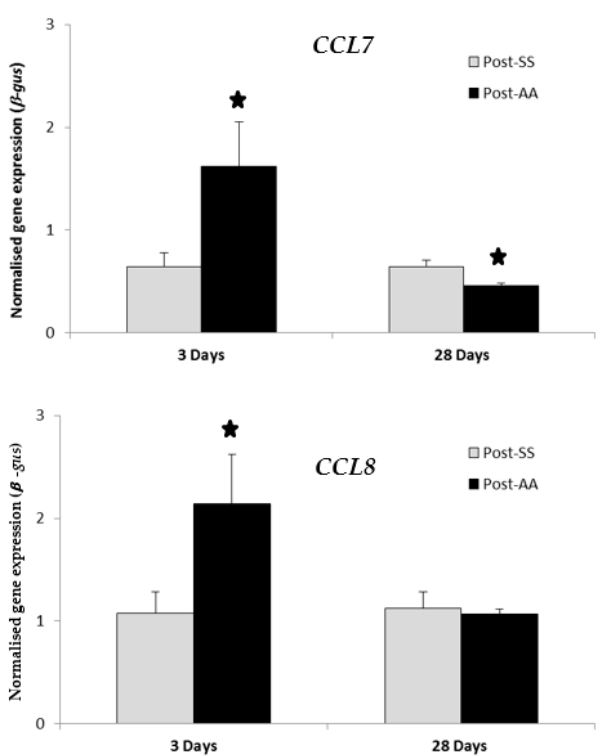
Figure 1. RT-PCR expression study of CCL7 and CCL8 chemokines three days post-AA and 28 days post-AA. RT-PCR transcript levels of chemokines CCL7 and CCL8 were compared in AA mice versus SS mice at either three days or 28 days after the second surgery. Expression of both CCL7 and CCL8 were significantly increased by AA three days after the second surgery when compared to controls (SS). Expression of CCL7 was significantly decreased by AA 28 days after the second surgery when compared to controls (SS). Expression of CCL8 was decreased (not statistically significant) by AA 28 days after the second surgery when compared to controls (SS). AA, Appendicitis-appendectomy, SS, Sham-sham. * p value < 0.05.